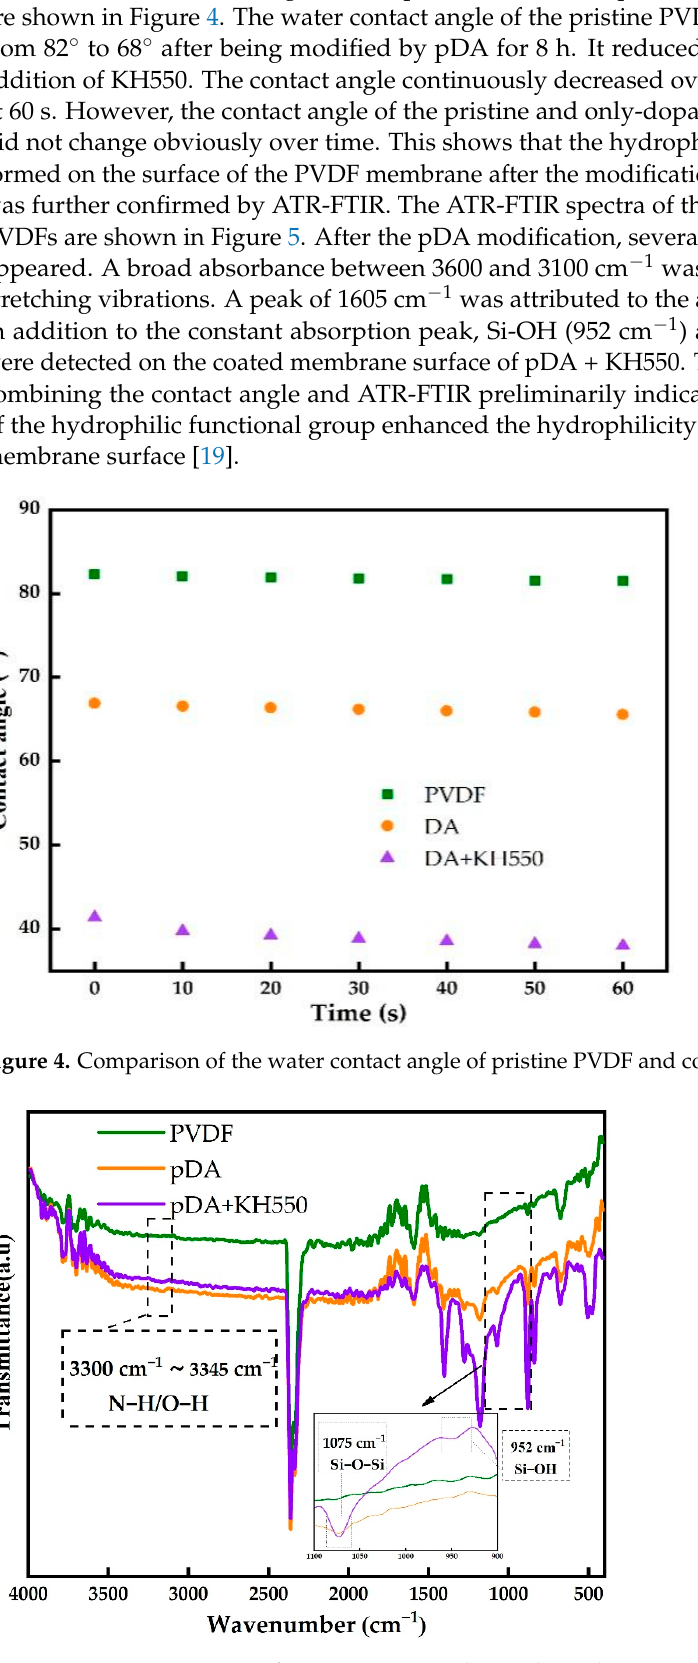
Figure 5. ATR-FTIR spectra of pristine PVDF and coated membranes.